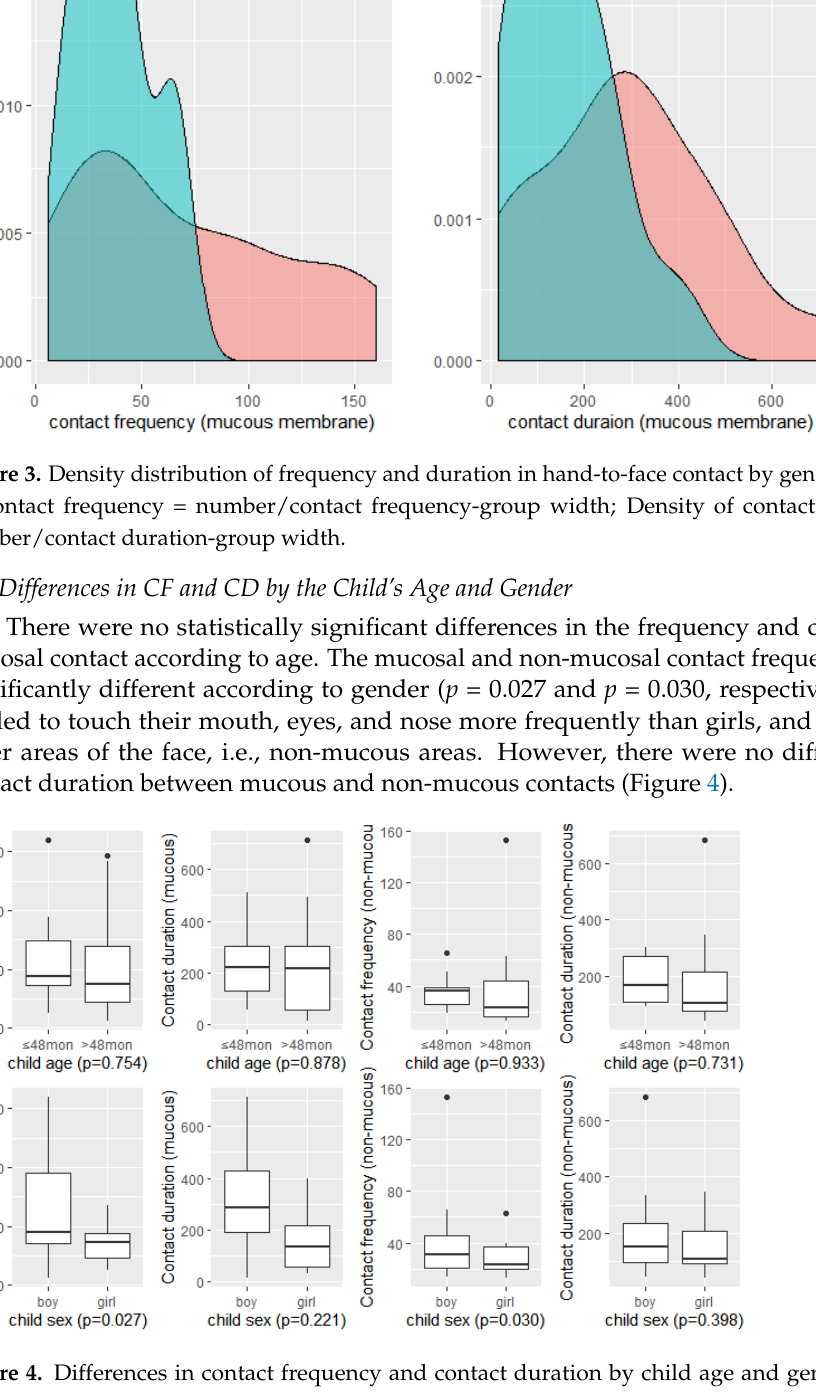
Figure 2. Visualizing frequency of hand-to-face contact (number/person/2 h). The color bar ex- presses the contact frequency from 0 to 25. The darker the color, the more frequent the contact.